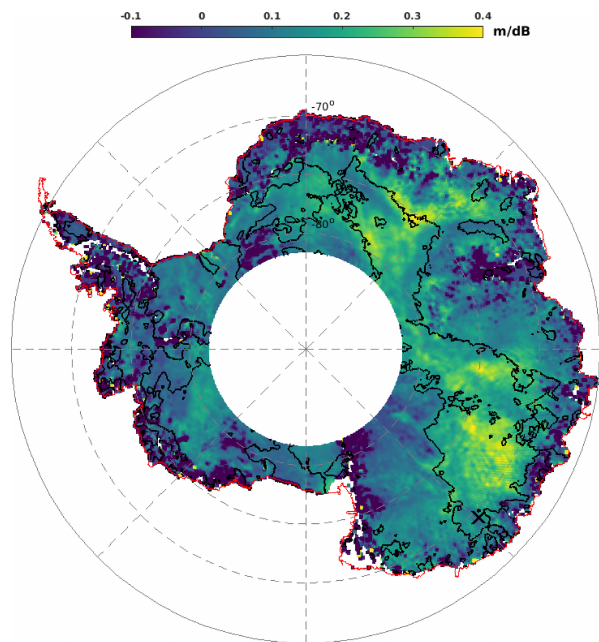
Figure 7. Temporal variations of the surface elevation residu- als with respect to the backscattering coefficient residuals at the Ku band (denoted hereafter, d h/ d σ 0 ) . Black contour lines delin- eate regions where the backscattering coefficient at the Ku band peaks before April. The cross mark represents the location of the time series shown in Fig. 1. White areas indicate regions where no observations are available (latitudinal orbit limit of 81.5 ◦ S). Values are expressed in mdB − 1